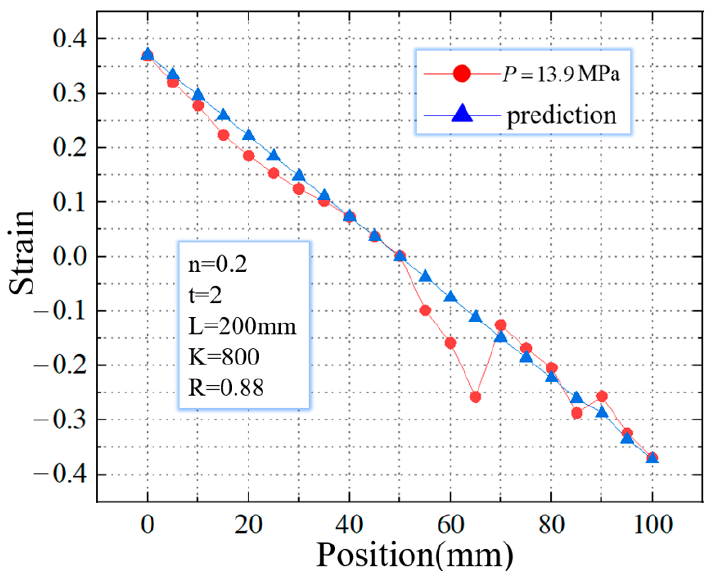
Figure 22. Strain distribution in cases of 11.9 MPa and 13.9 MPa.